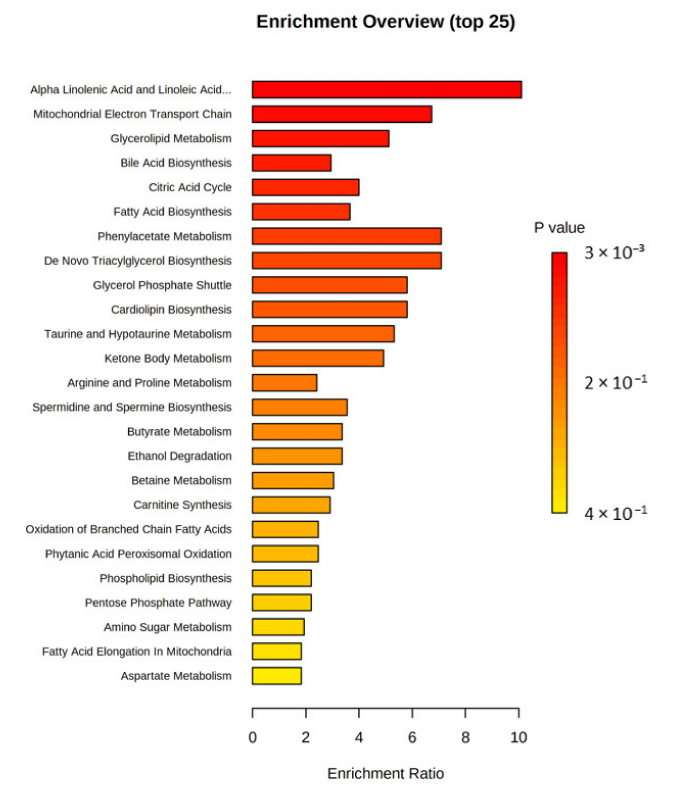
Figure 6. Results of the Metabolite Set Enrichment Analysis. Metabolite set enrichment analysis showed that seven differential pathways differed between the PD and control